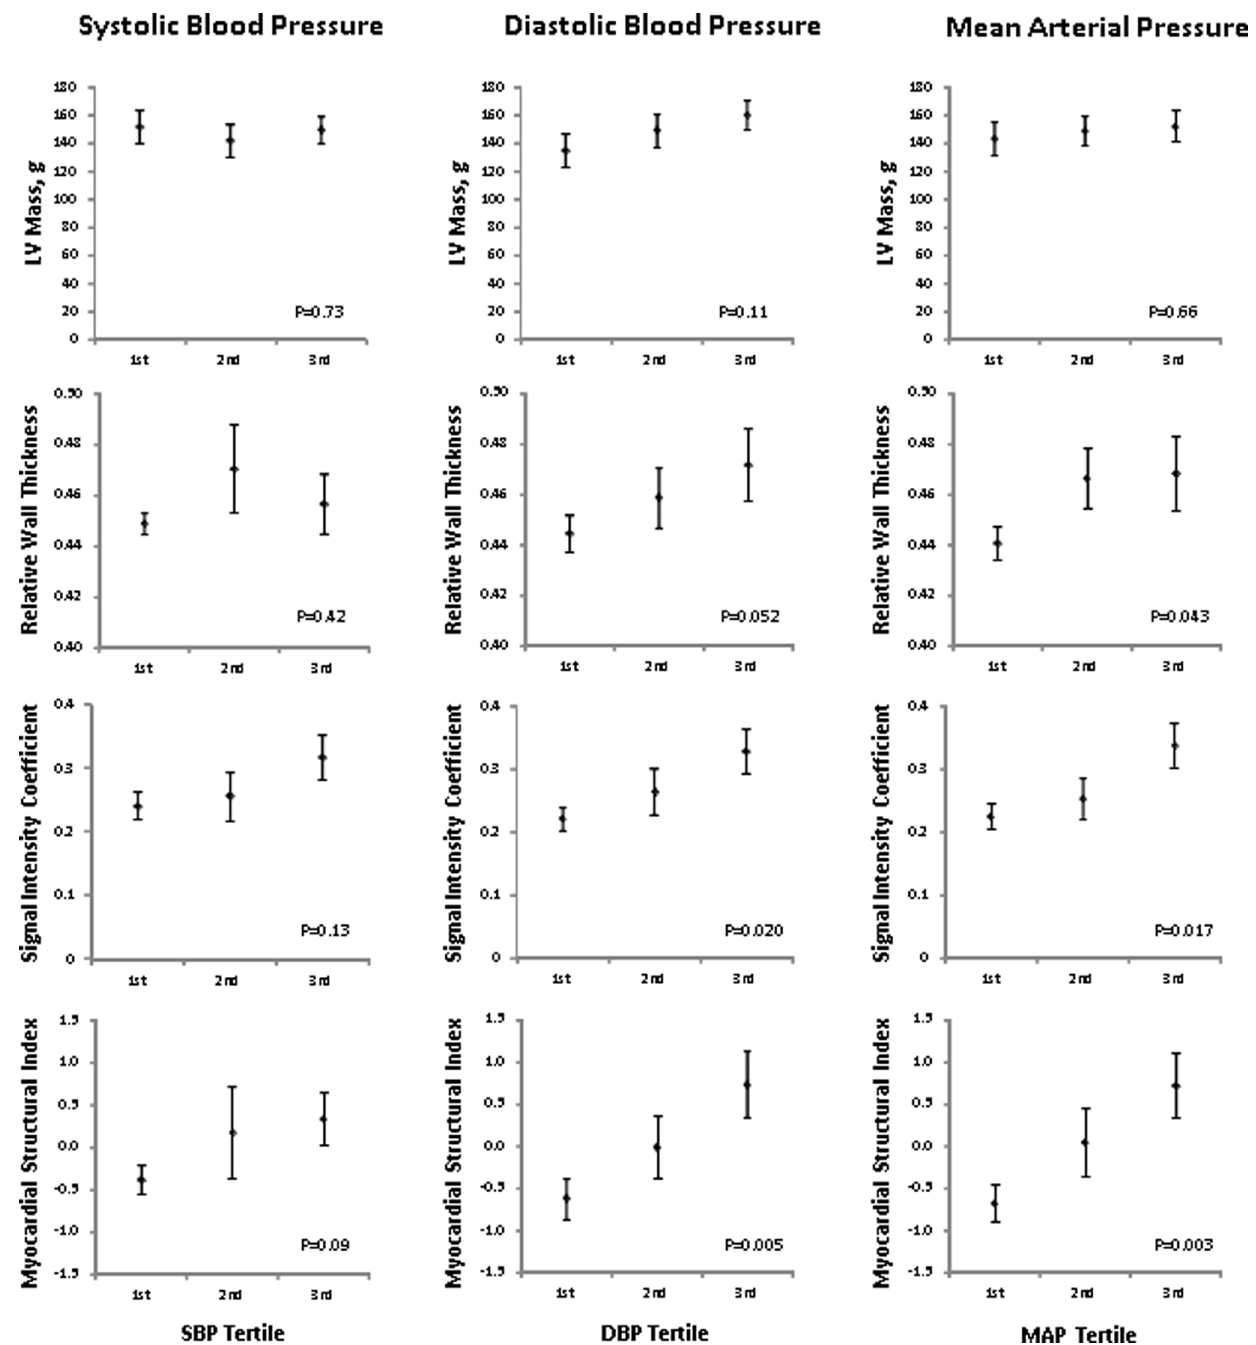
Figure 1. Mean ( ± standard error) values of conventional and advanced echocardiographic measures are displayed across increasing tertile of systolic, diastolic, and mean arterial pressure in the total study sample. Conventional echocardiographic measures include left ventricular mass and relative wall thickness; advanced measures include the signal intensity coefficient and myocardial structural index. P values are for non-parametric tests of trend cross tertiles of each blood pressure